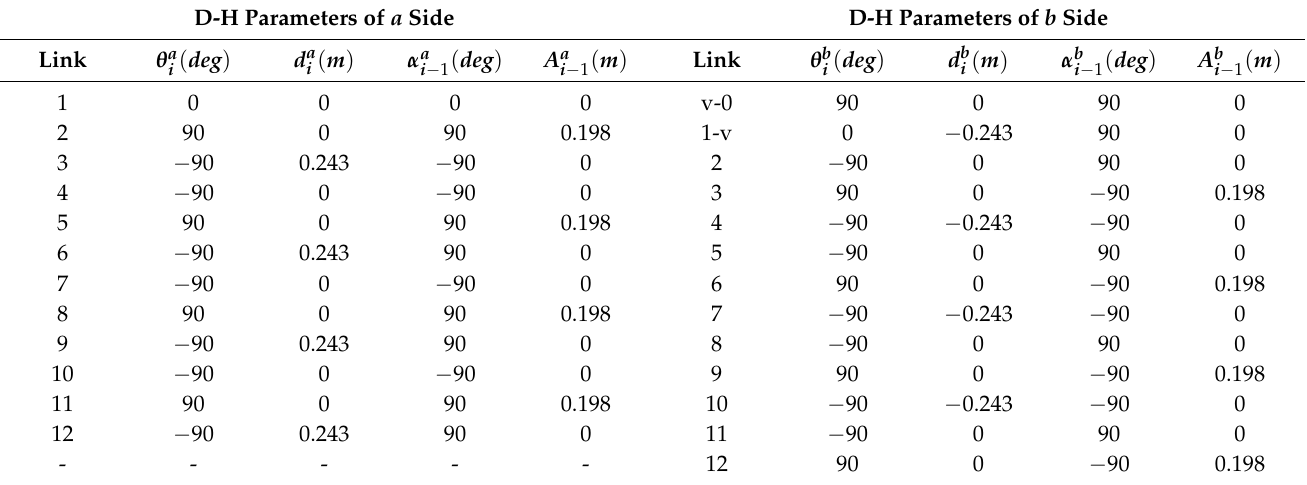
Table 1. D-H parameters of